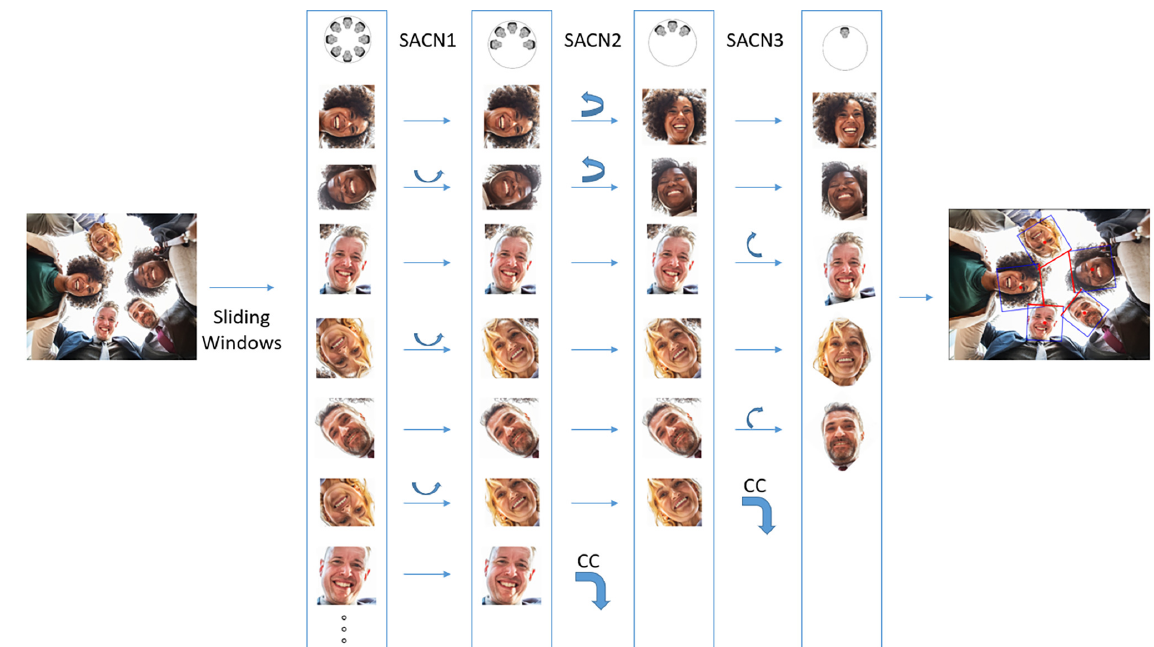
Figure 3. The Searching Architecture Calibration Network (SACN) process.